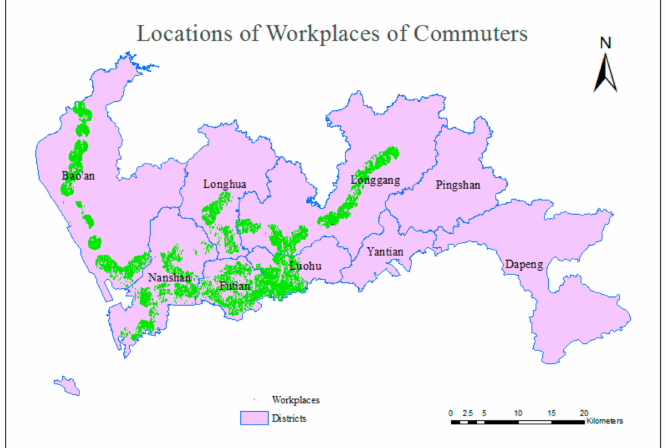
Figure 7. Locations of the workplaces of selected